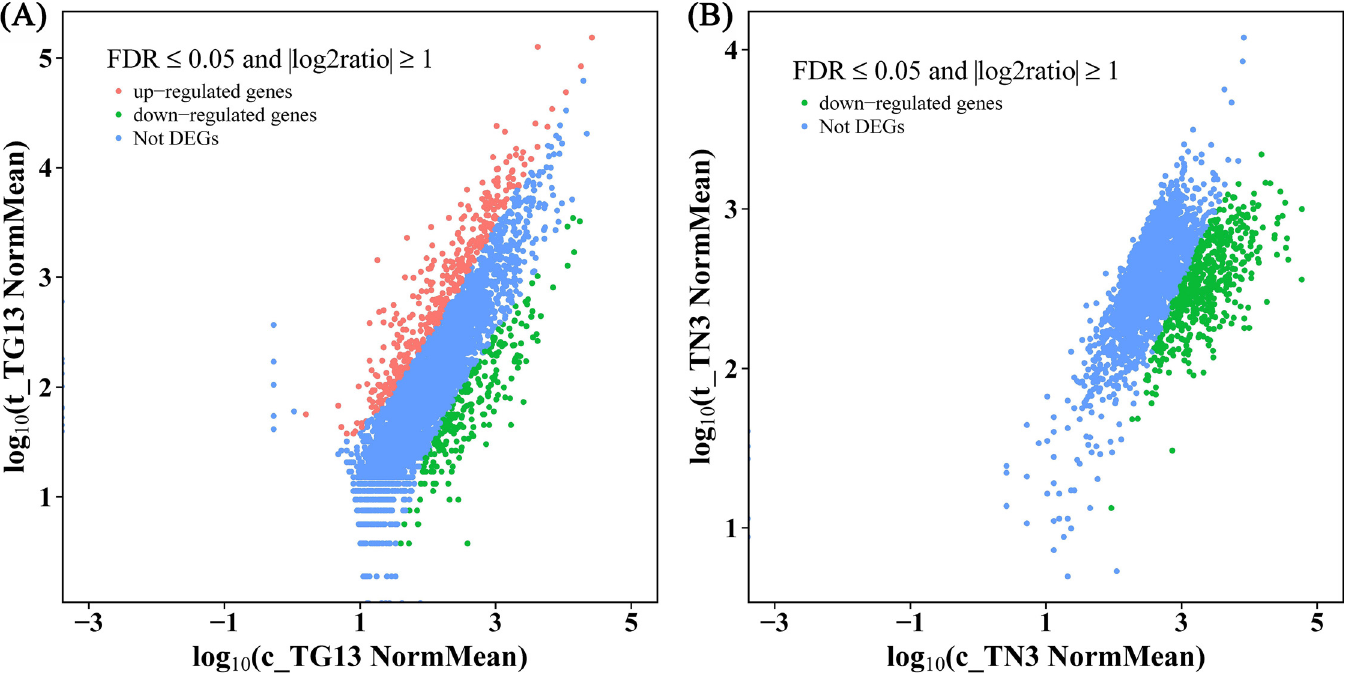
Fig 3. Differential expression levels of the exponential-phase cells and VBNC cells in Rhodococcus sp. strains TG13 (A) and TN3 (B). The absolute value of log2 ratio (cid:3) 1 and the false discovery rate (FDR) (cid:4) 0.05 were used as the